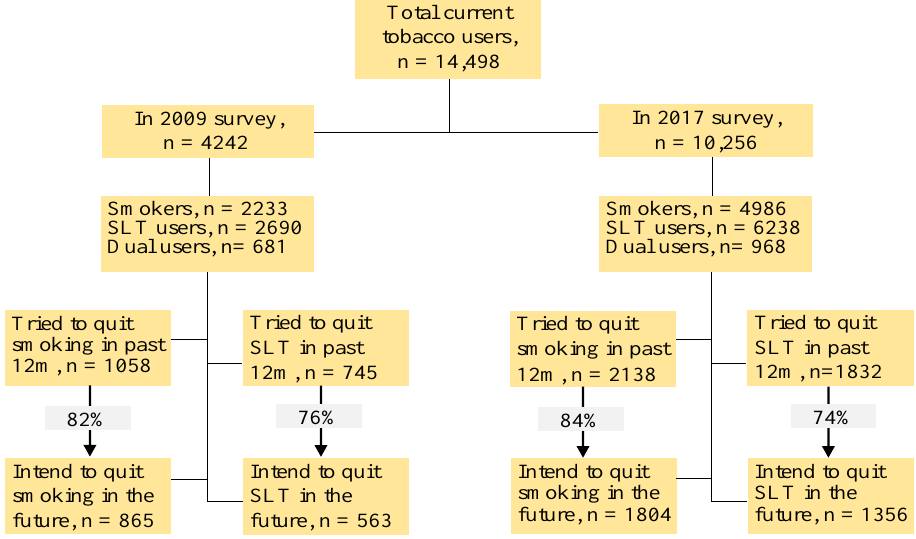
Figure 1. Flowchart of the two rounds of survey participants, presenting the total and two types of tobacco users, their quitting attempts in the 12 months before the survey, and their intentions to quit in the future. Note: SLT — smokeless tobacco; 12 m — 12 months .